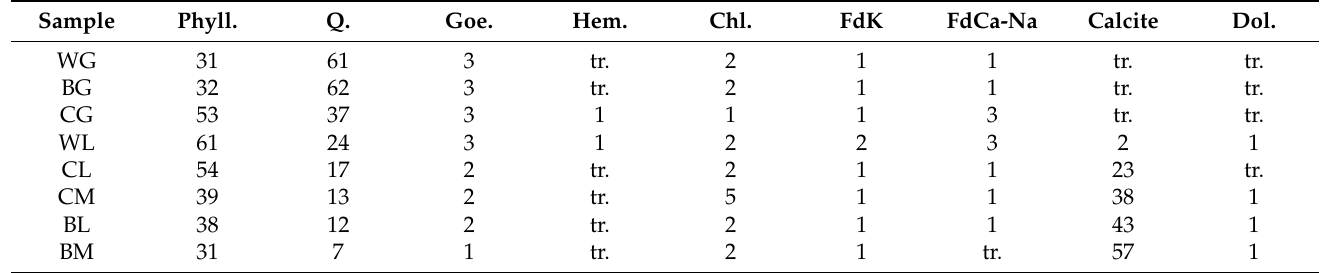
Table 3. Mineralogical composition of the fine-earth fraction (<2 mm; DRX- disoriented powder. %) of the